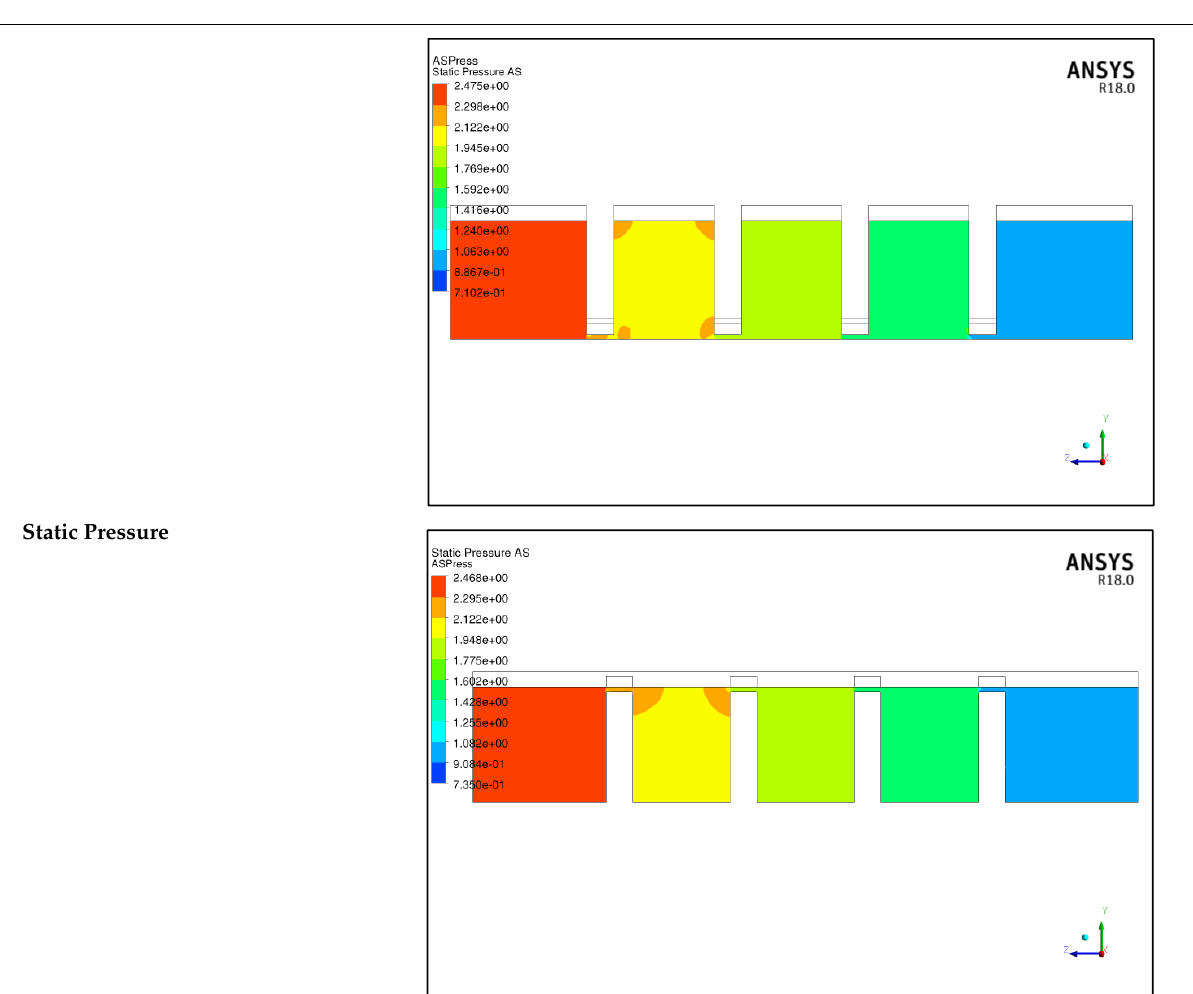
Table A6. Static pressure fields.